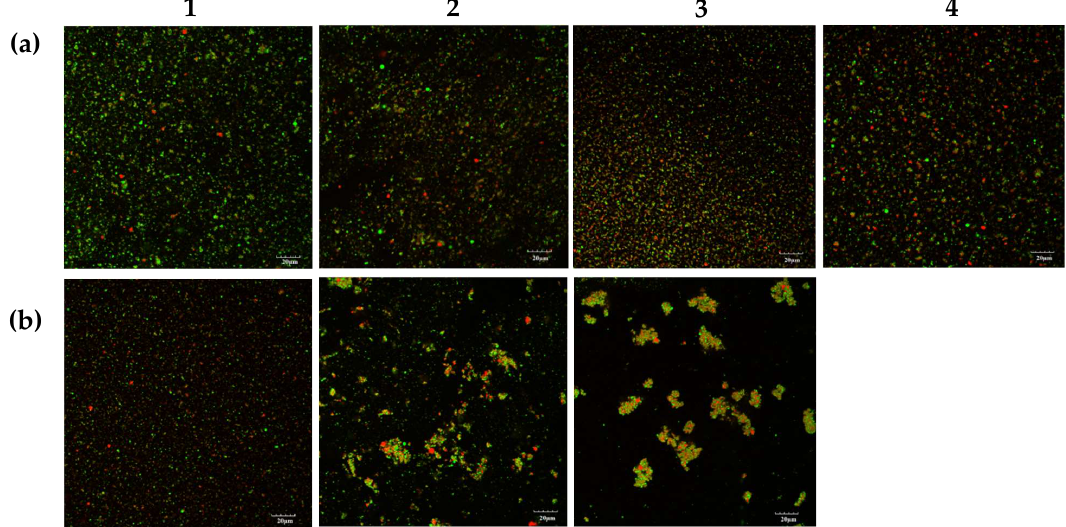
Figure 8. Confocal laser scanning micrographs of emulsions ( a ) before and ( b ) after heat treatment in an oil bath at 140 °C for 2 min with 0 (a 1 or b 1 ), 4 (a 2 or b 2 ), 6 (a 3 or b 3 ) and 10 (a 4 ) mM calcium chloride. The 10 mM sample after heating was not analysed due to extensive aggregation. Protein = red; oil = green. Scale bar (bottom right) is 20 µm.